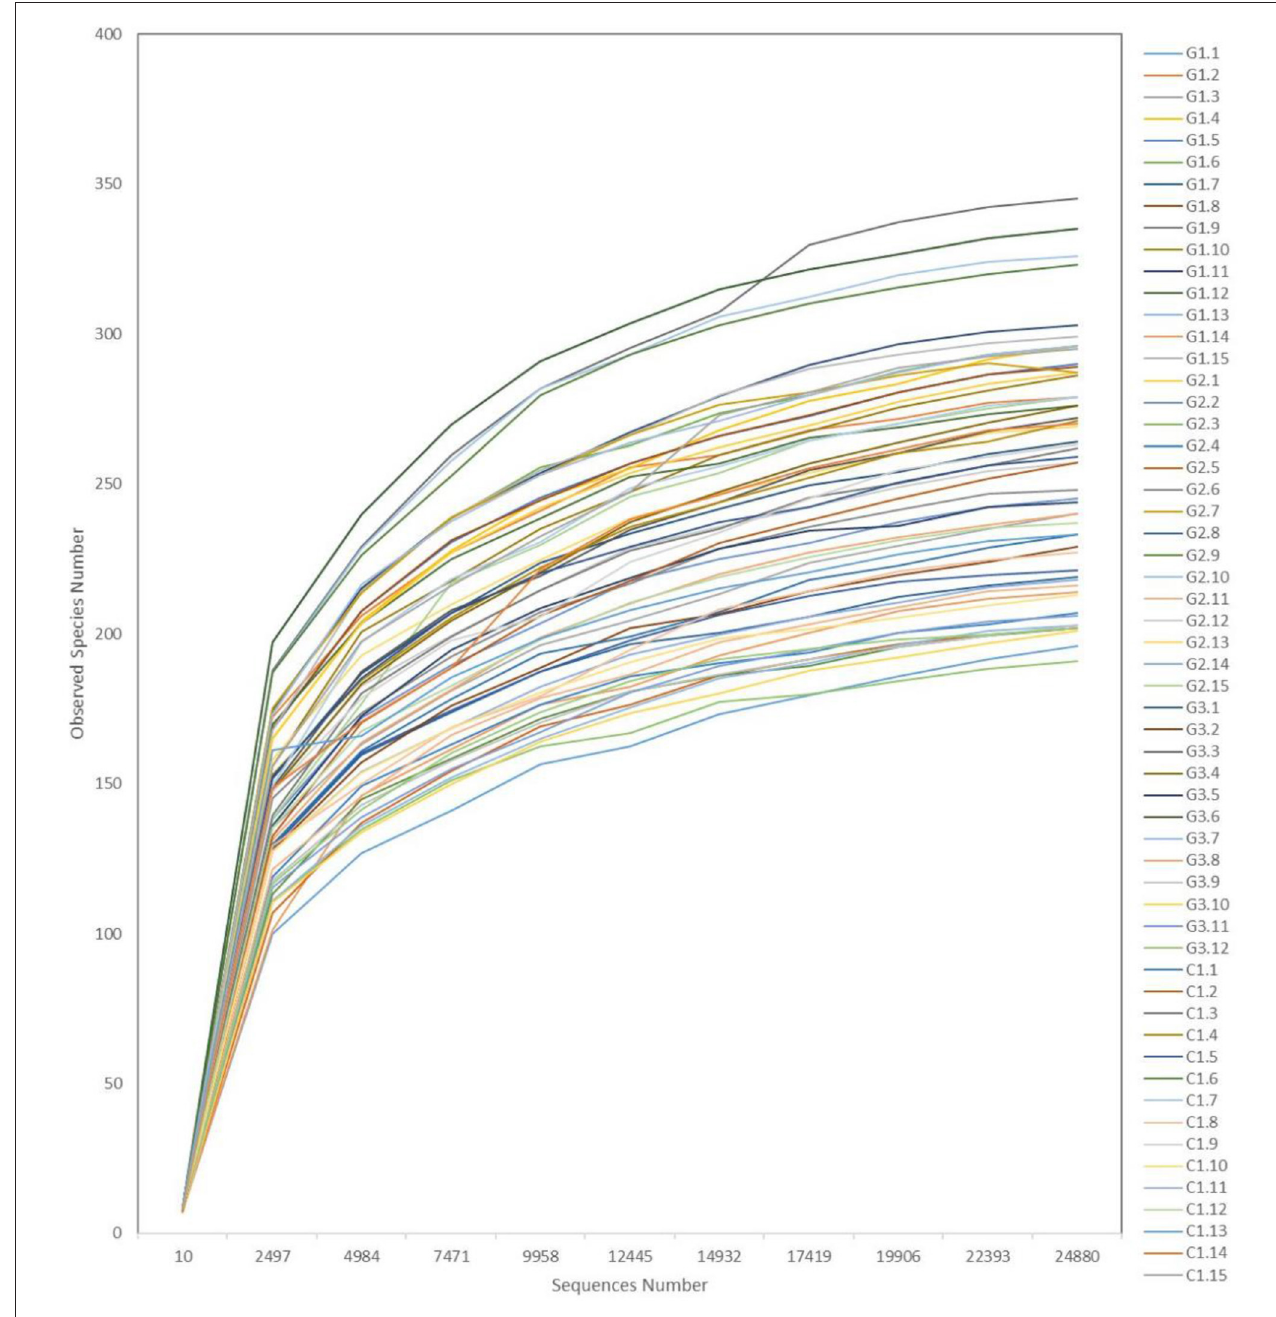
FIGURE 6 | Representative rarefaction curves. The abscissa is the number of valid sequences per sample, the ordinate is the number of operational taxonomic units (OTUs) species observed. Each curve represents a different sample. most abundant bacteria in the intestinal flora of